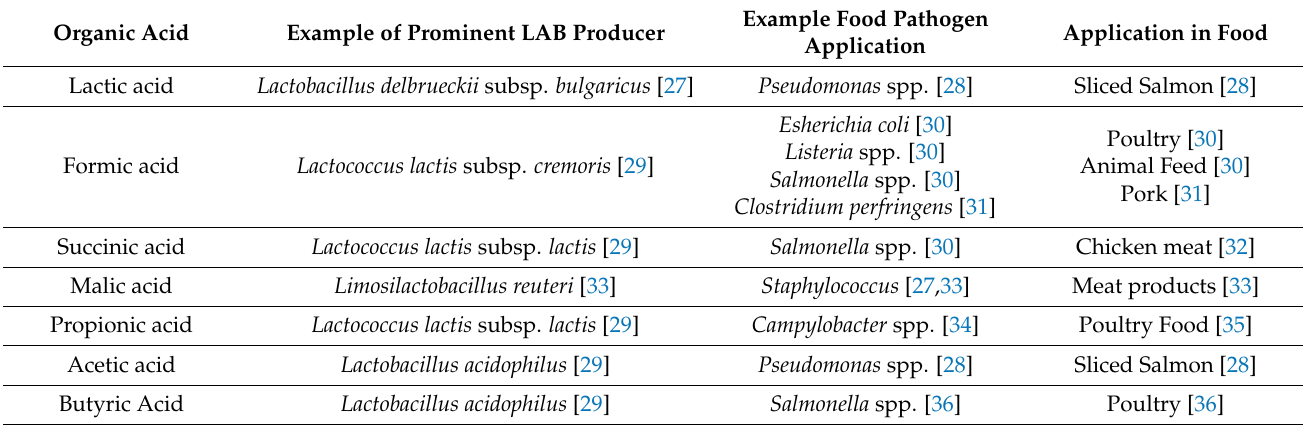
Table 2. Organic acids and their applications in